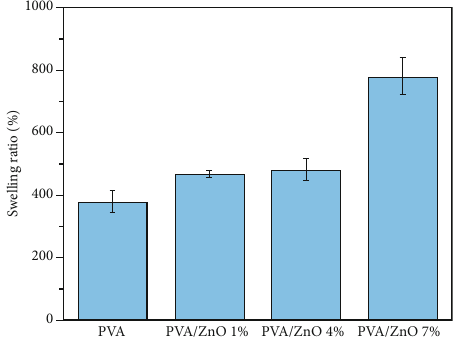
Figure 5: Swelling ratio of PVA nano fi ber and PVA/ZnO nano fi bers.